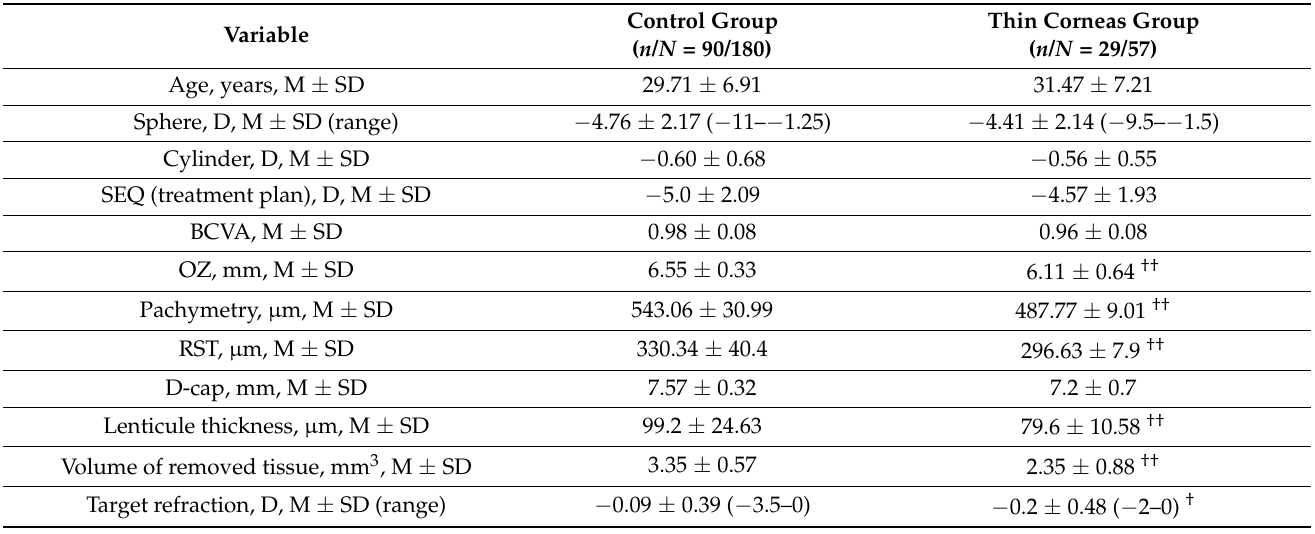
Table 1. Baseline patient